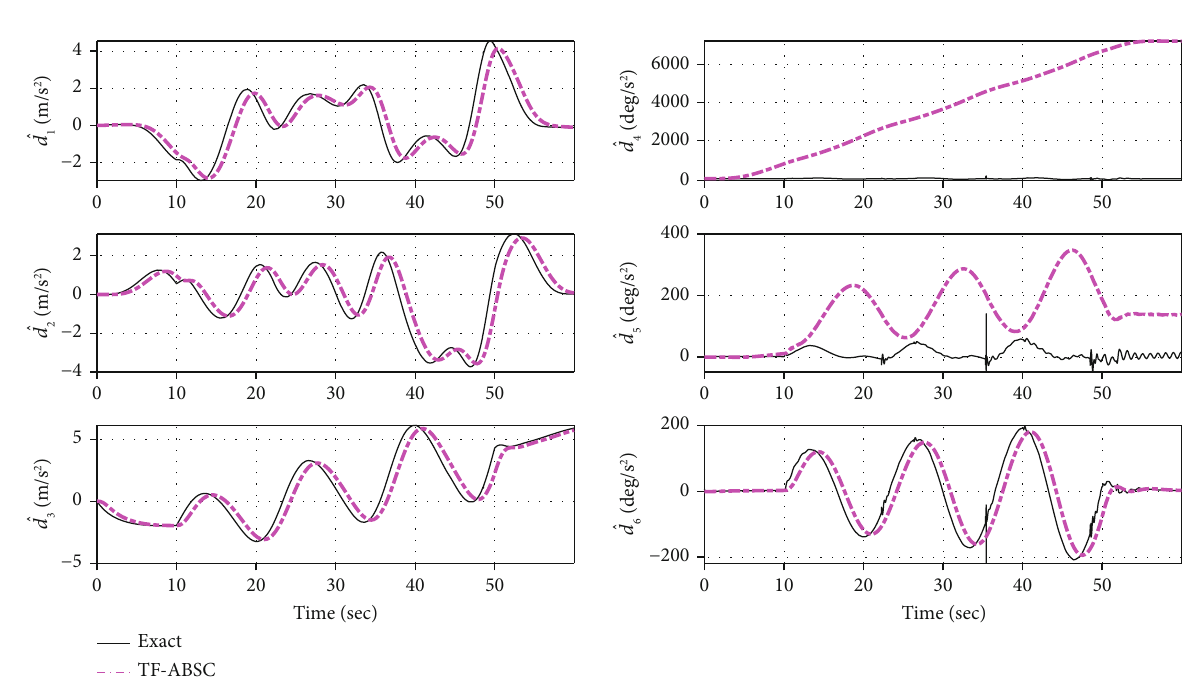
Figure 13: Case B: estimation results of I&I-ABSC.